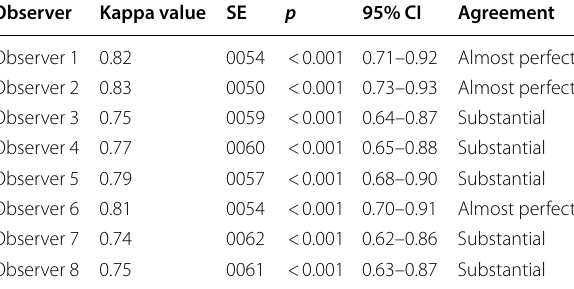
SE standard error, 95% CI confidence interval